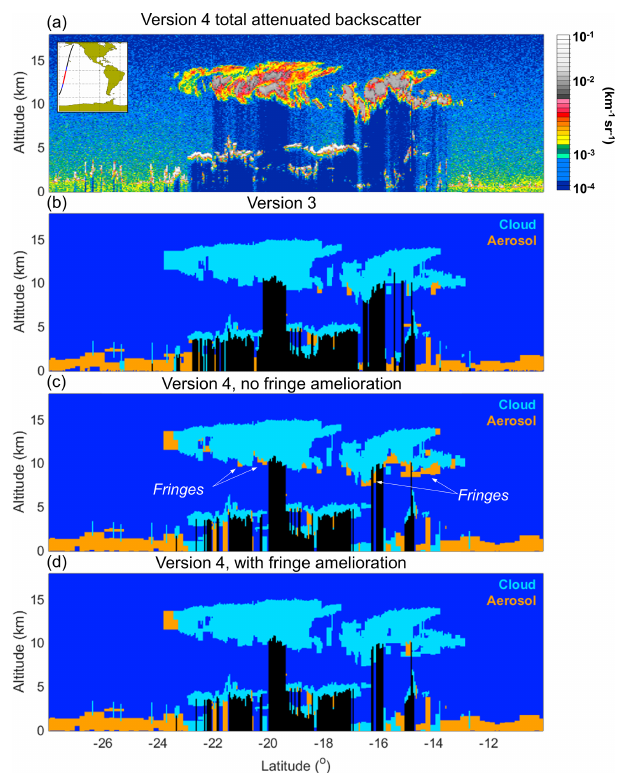
Figure 6. V4 532nm total attenuated backscatter (a) and cloud– aerosol classification for V3 (b) and V4 without (c) and with (d) cirrus fringe amelioration for the granule 2008-06-01T12-27-28ZN. Red line on inset map shows approximate ground track.